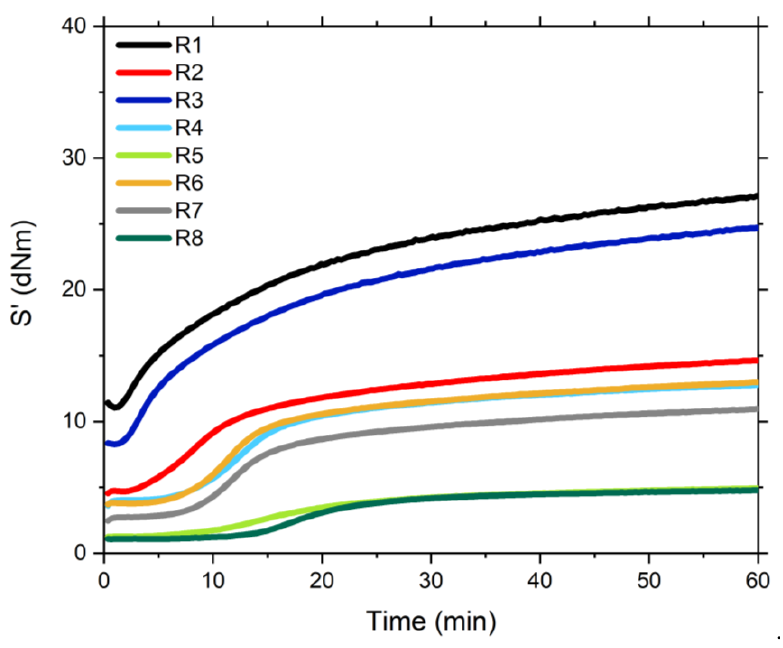
Figure 5. Vulcanization curves of the studied samples.